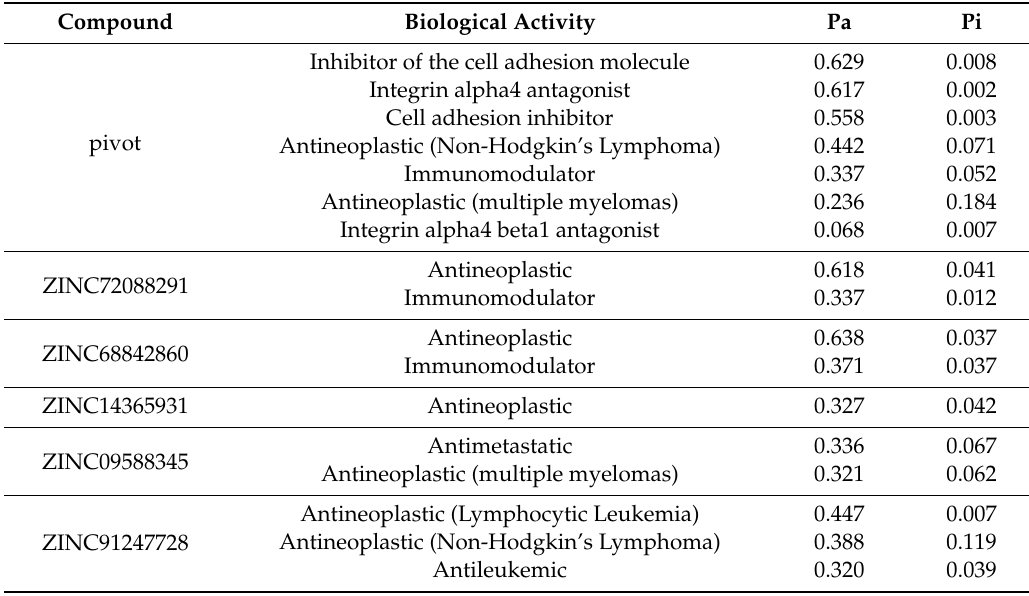
Table 7. Prediction of biological activity for compounds resulting from virtual screening.